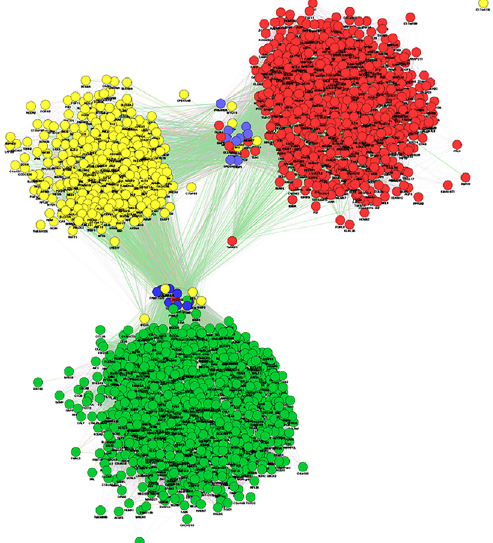
Fig 5. Overlap of inferred networks of differentially-regulated genes and genes that are potentially controlled by HIF-1. Genes that were significantly upregulated in the pituitary after hypoxia are represented as a network with red nodes (as in Fig 1). Genes that were significantly downregulated in the pituitary after hypoxia are represented as a network with green nodes (as in Fig 1). Genes with HIF-1 consensus binding sites in their putative promoter regions (-2 to +2 kB) are represented as yellow nodes. Genes that were found to be in both the red- and yellow networks, and genes that were found to be in both the green- and yellow- networks after network merge are colored blue. The merged network is represented in a force-directed